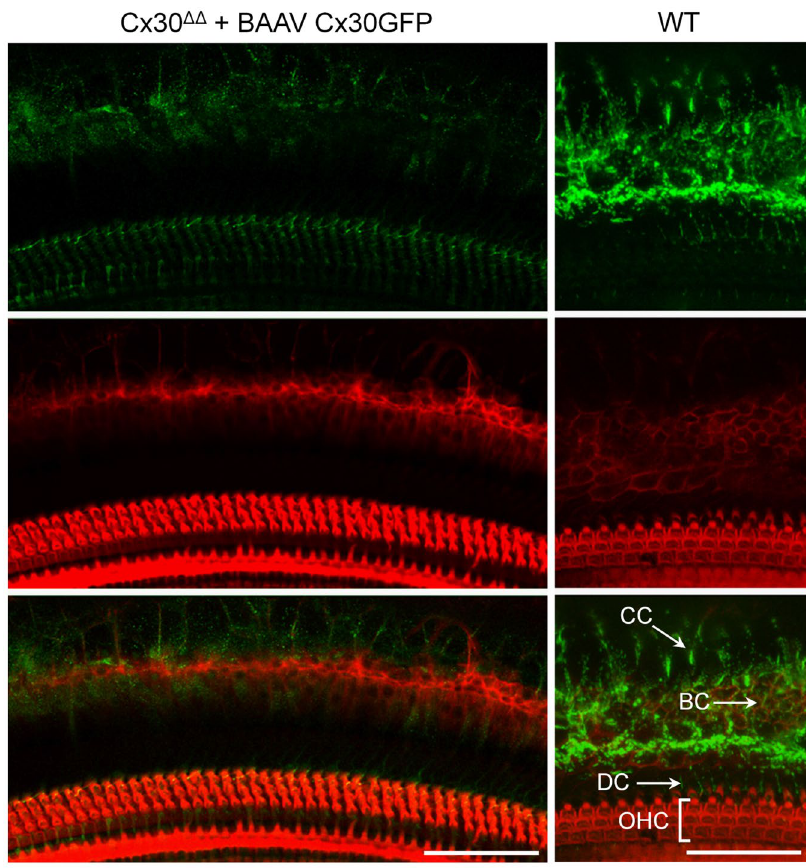
Figure 6. Cx30 expression in the organ of Corti of Cx30 Δ / Δ mice four weeks after delivery of BAAVCx30GFP viral vector at P4. Shown are whole mount preparations from injected Cx30 Δ / Δ mice (Cx30 Δ / Δ + BAAVCx30GFP) and non-injected wild type age-matched controls (WT). The green signal was generated by immunostaining against GFP (Cx30 Δ / Δ + BAAVCx30GFP) and native Cx30 (WT),